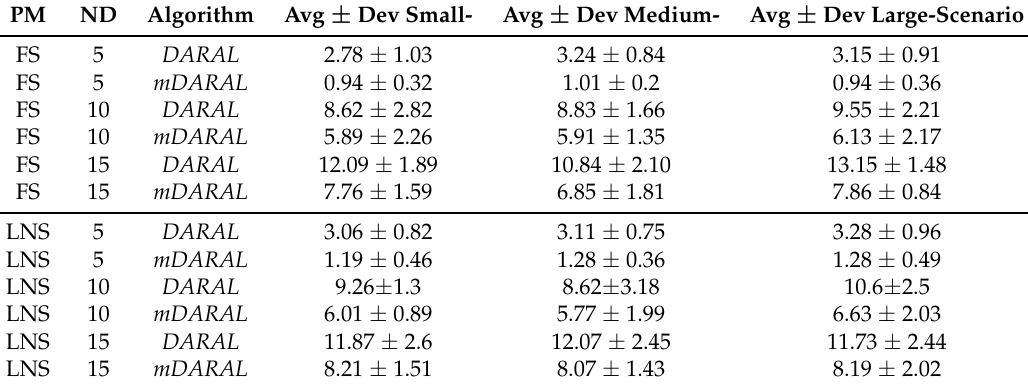
Table 5. Average convergence time for small-, medium- and large-size scenarios under different propagation conditions. ND and PM stand for Node Density and Propagation Model